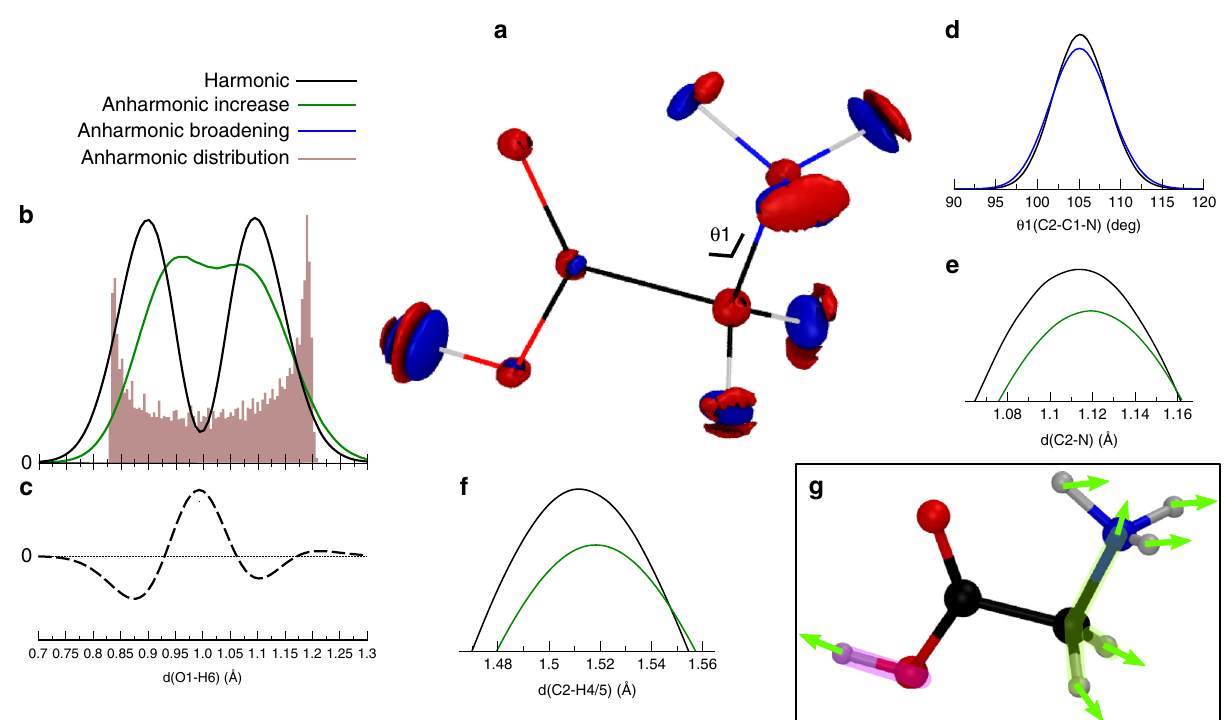
Fig. 3 Comparison of harmonic and anharmonic nuclear densities for the O-H stretch vibrational excited state. a The same as in Fig. 2b but for the O – H stretch vibrational excited state. b – f Relevant geometry parameter distributions with the same color code as in Fig. 2. The solid black curves are obtained from the harmonic approximation of the wavefunction, while the colored ones are calculated from the full anharmonic wavefunction. Green curves present the maximum shifted towards longer bond lengths (Anharmonic increase), while the blue one stands for broadening of the anharmonic distribution with respect to the harmonic one and without maximum shift (Anharmonic broadening). Speci fi cally, b Bond-length distributions along the radial O1 – H6 stretch distance. The fi lled area is the histogram of the classical distribution obtained from the quasi-classical trajectory used to generate the semiclassical wavefunction. The harmonic normal mode distribution is small but not equal to zero at equilibrium distance because the variation of O – H stretch normal mode does involve, even if minimally, also other atom displacements. c Difference between anharmonic and harmonic curves of b . The statistical error bars for the distributions are smaller than the line width. d C2 – C1 – N angle distribution. f , e enlargement of the distribution peaks for the C2 – H4/5 and C2 – N bond distances. g Summary of the overall effect of anharmonicity and couplings on the quantum nuclear density which leads to speci fi c nuclear density redistribution (indicated by the green arrows) giving effects which counterbalance each other in two separate regions of the molecule, the hydroxyl (highlighted in magenta) and the CH 2 NH þ (highlighted in green). These are deduced from the consideration of geometrical parameters distributions 3 reported in b , f , e , d , and in the Supplementary Figs. 4,